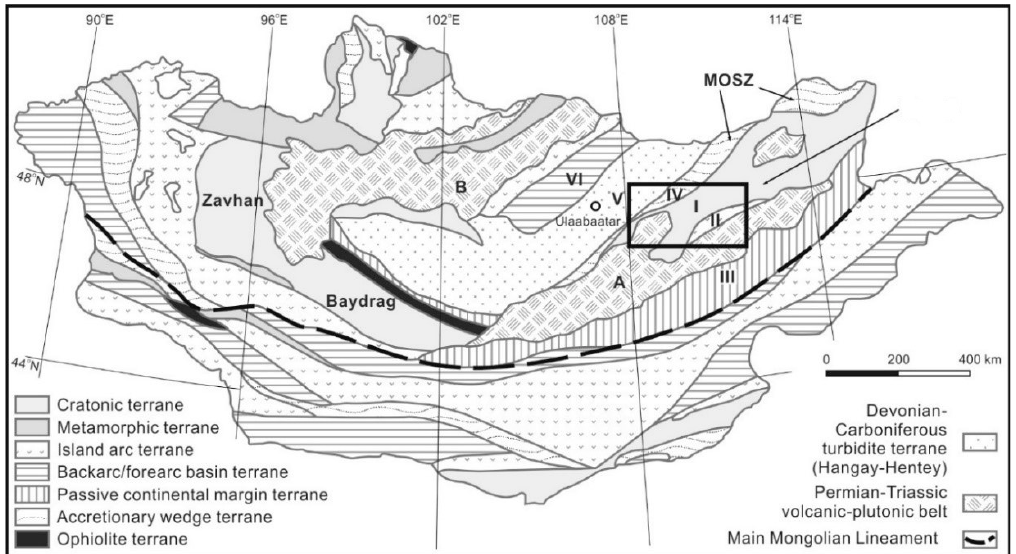
Figure 2. Sketch map showing tectonostratigraphic terranes of Mongolia and the approximate location of the study area of this paper (adapted from [13]). Terrane and belt names: I—Ereendavaa, II—Kherlen, III—Idermeg, IV—Adaatsag (Onon); V—Hangay-Hentey; VI—Haraa; A—Middle Gobi,